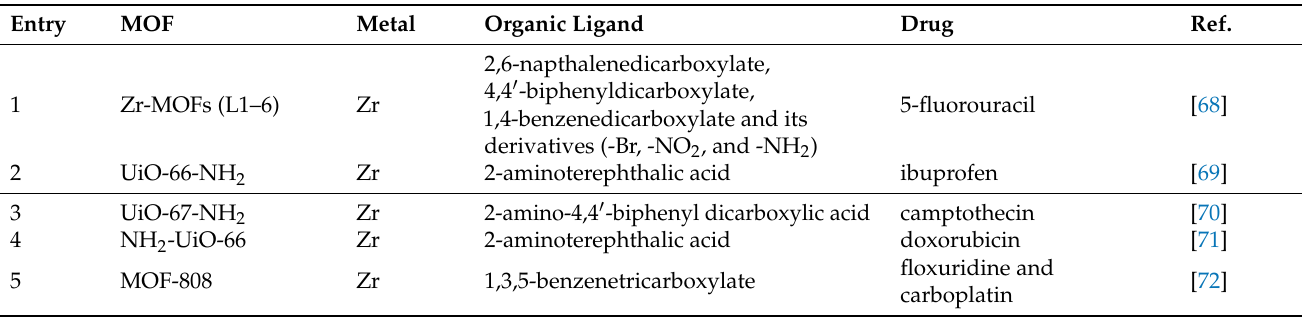
Table 1. Some representative MOF-based nanocarriers for drug